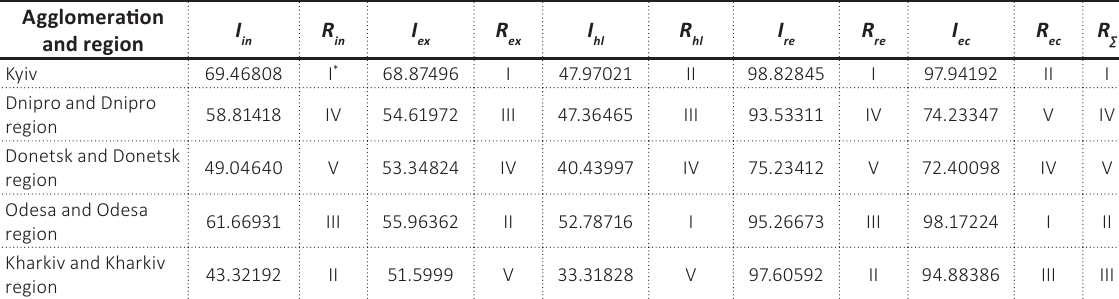
Kharkiv and Kharkiv region